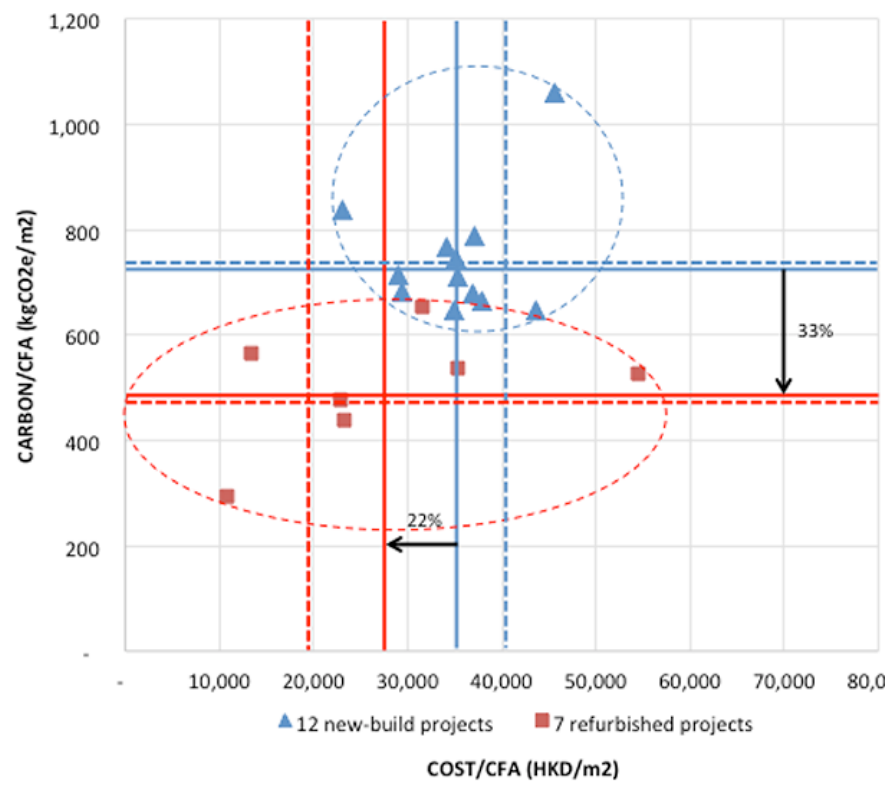
Figure 6 New-build versus Refurbished EC and Cost Comparison (Hong